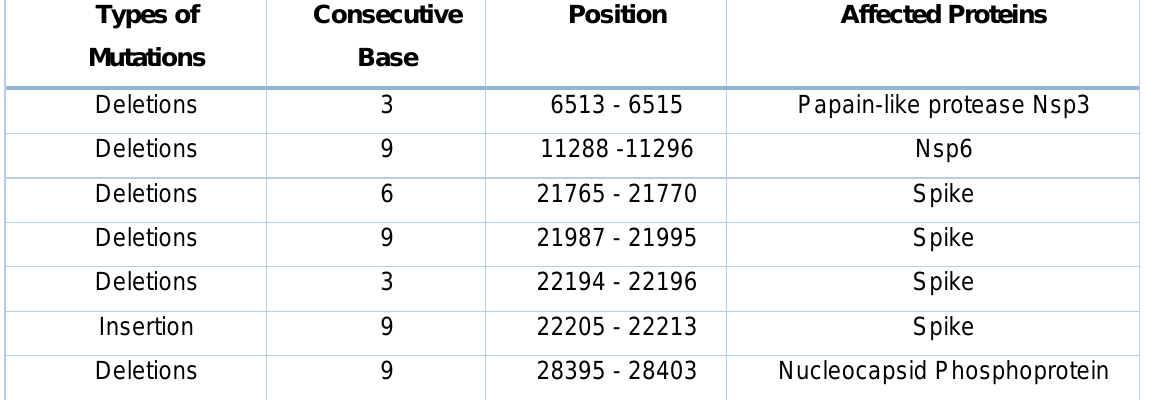
Table 1: Consecutive mutations in omicron variant (Data source: Parvez et al.,